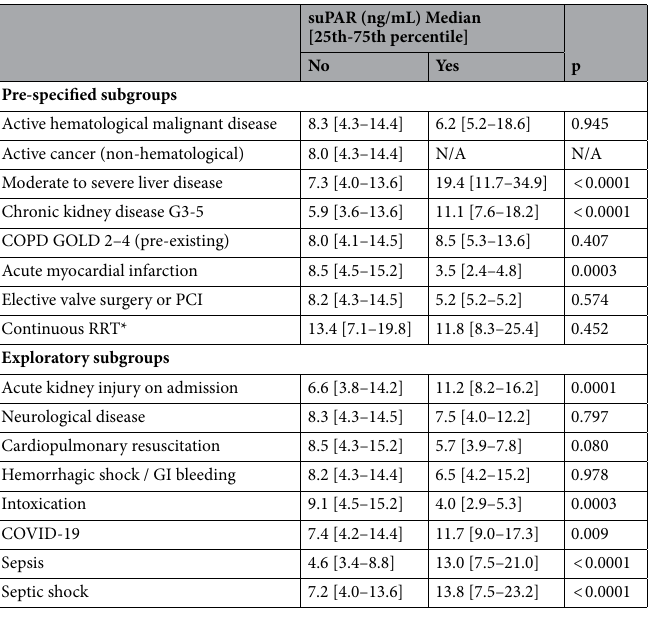
Table 2. suPAR in prespecified and exploratory subgroups. Note that a patient may be in more than one group. * Out of 55 patients who received dialysis. suPAR = soluble urokinase plasminogen activator receptor; N/A = not applicable; COPD = chronic obstructive pulmonary disease; GOLD = global initiative for chronic obstructive lung disease; PCI = percutaneous intervention; RRT = renal replacement therapy; GI = gastrointestinal; COVID-19 = coronavirus disease